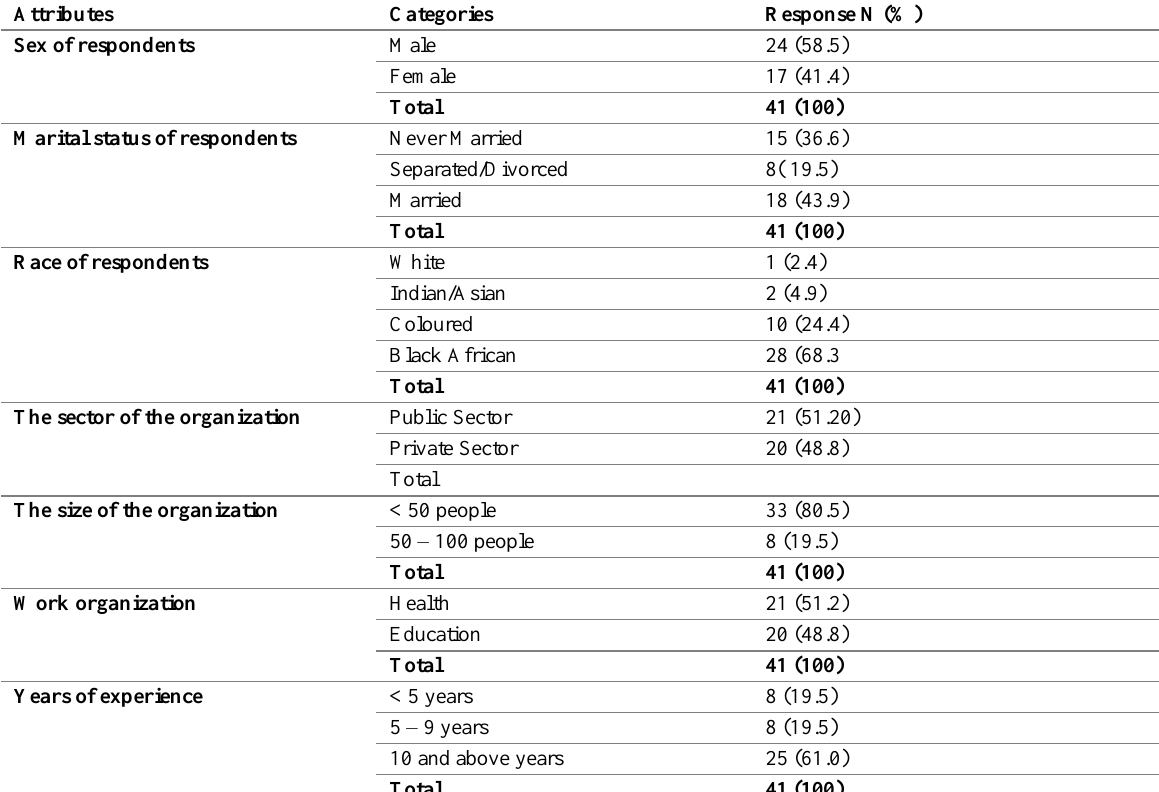
Table 1: Socio-demographic distribution of